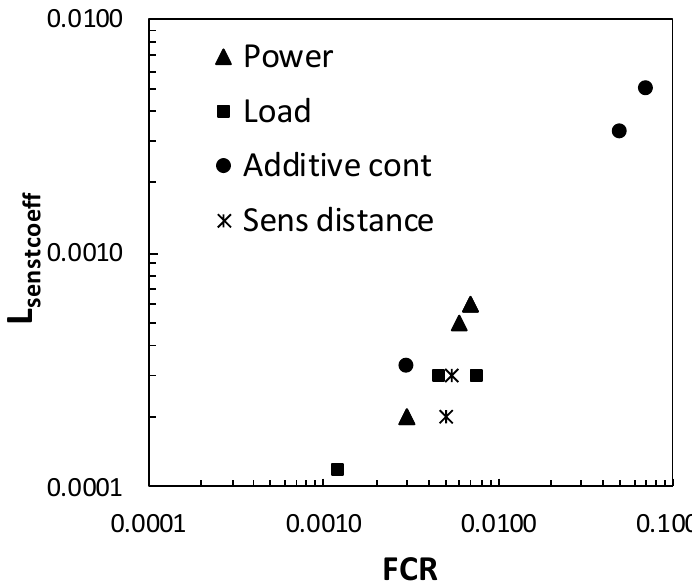
Figure 12. Relationship for Lsencoeff and FCR in the parameters studied for the performance and